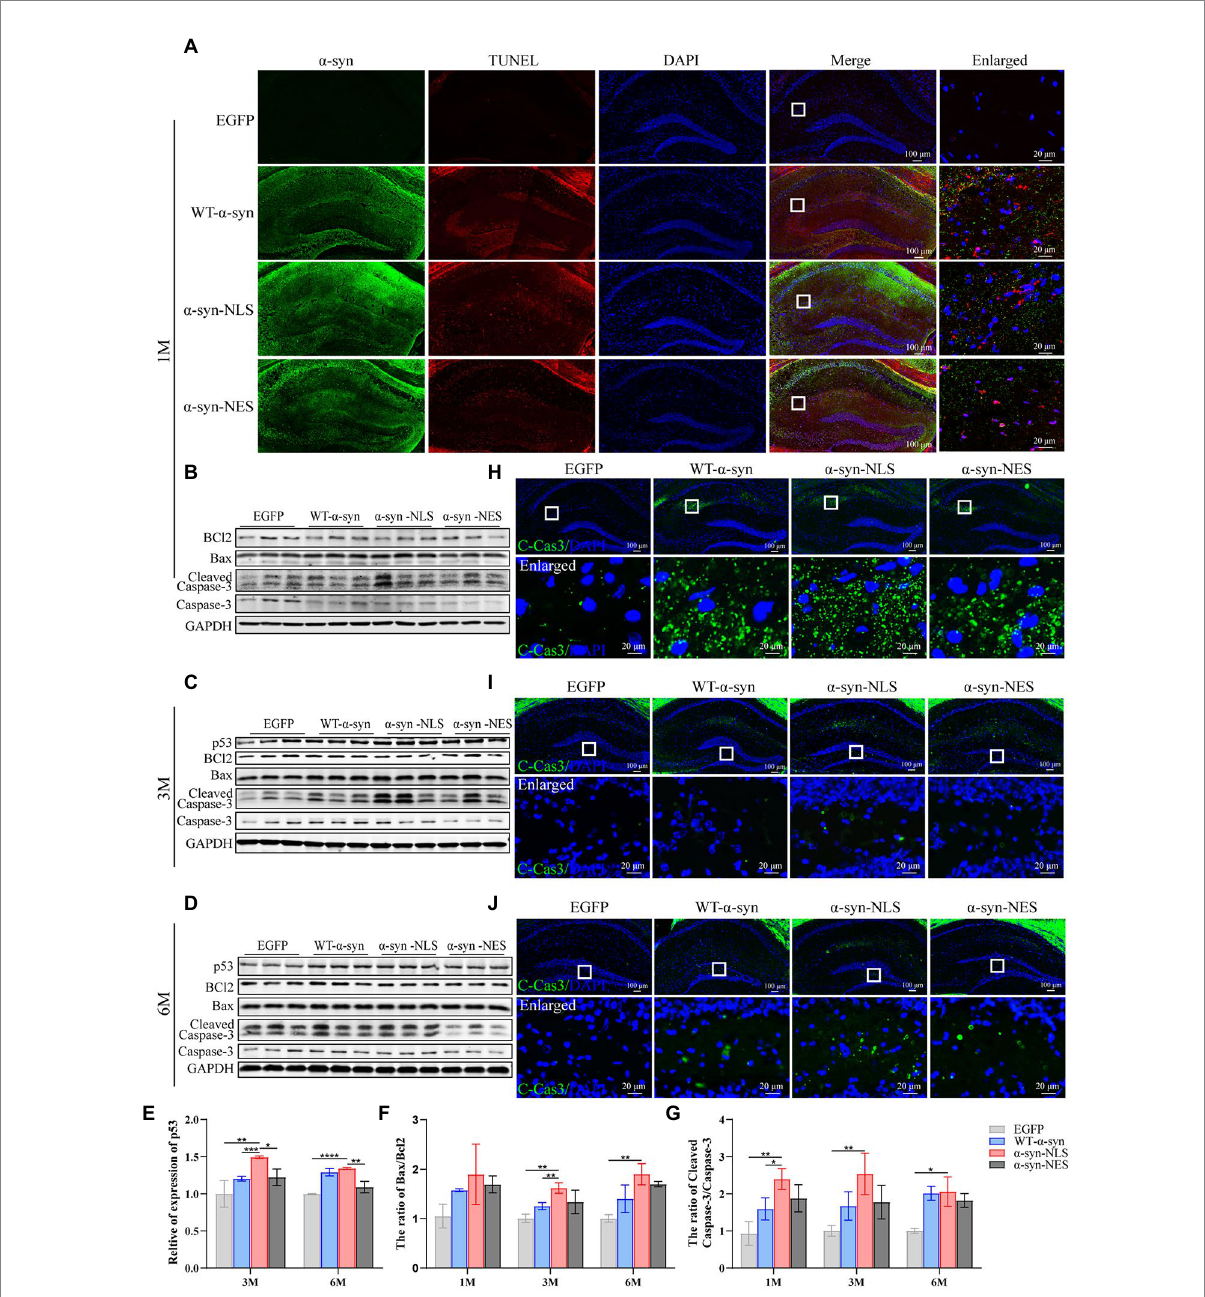
FIGURE 8 Nuclear localized α -syn causes neuronal apoptosis in the mouse hippocampus. (A) TUNEL staining in the hippocampus at month 1 after virus injection. (B–D) Western blot of mouse hippocampus at months 1, 3, and 6 after virus injection with p53, BCl2, Bax, Cleaved Caspase 3 (C-Cas3), and Caspase 3 antibodies ( n = 3). (E–G) Relative levels of proteins (ratio to GAPDH) in western blot ( n = 3). (H–J) Immunofluorescence staining of mouse hippocampus with C-Cas3 (green) antibody at months 1, 3, and 6 after virus injection; DAPI was used to stain all nuclei (blue). * p < 0.05, ** p < 0.01, *** p < 0.001, **** p <